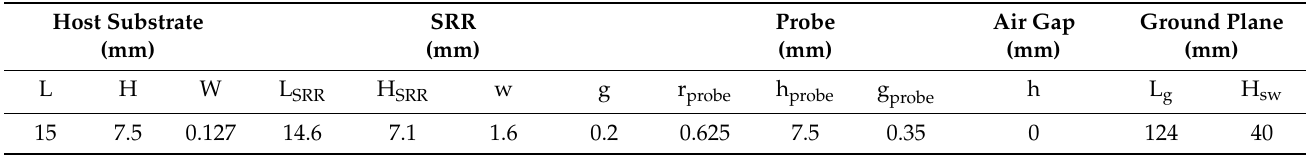
Table 5. Dimensions of the fabricated 1x(cid:4652)⃑ × 1y(cid:4652)⃑ × 1z⃑ split ring antenna.